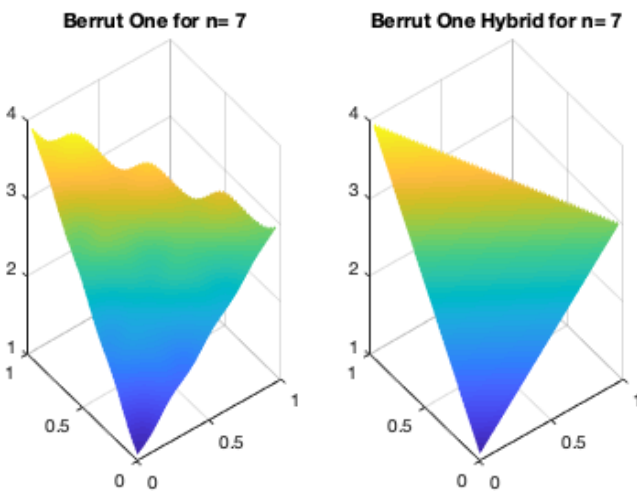
Figure 8. Berrut One and its Hybrid for n = 7 and f ( x , y ) = 1 + 2 x + 3 y